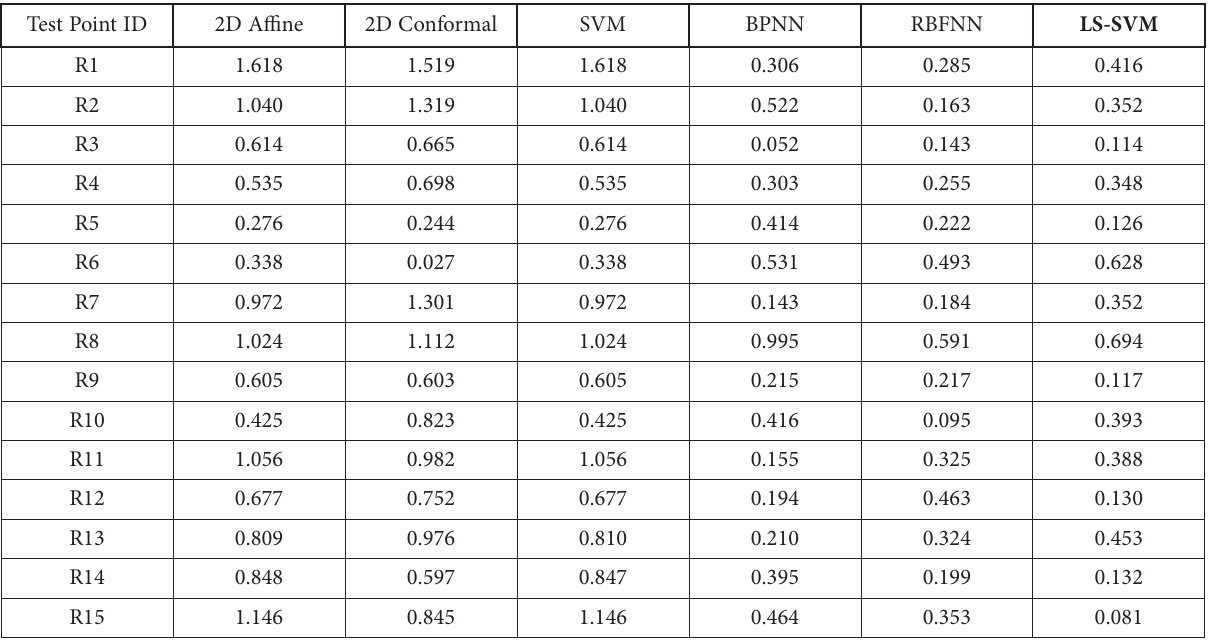
Table 3. Horizontal coordinate residuals from the various methods (unit: meters) Test Point ID